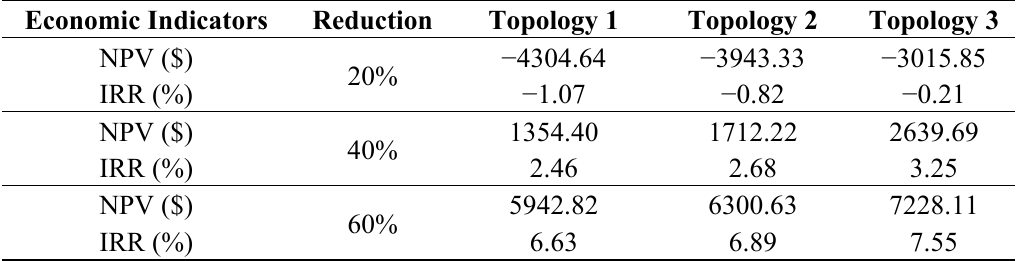
topologies considering equipment cost reductions of 20%, 40% and